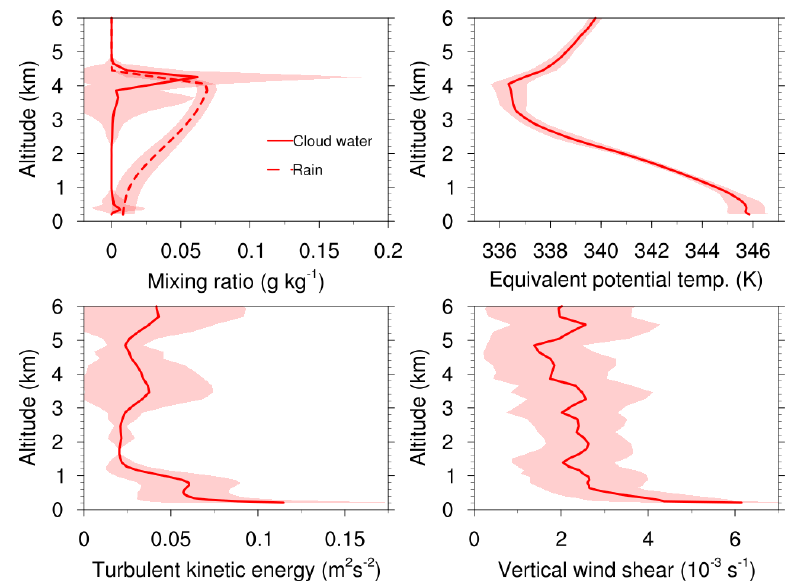
Figure 12. Vertical profiles of mean cloud and rain water, equivalent potential temperature ( θ e ), turbulence kinetic energy (TKE), and vertical wind shear inside the simulated tracked warm-rain cells with depths smaller than 2 km. The shaded contours correspond to the standard deviation among the individual profiles of the warm-rain cells. Individual profiles are taken at their center of